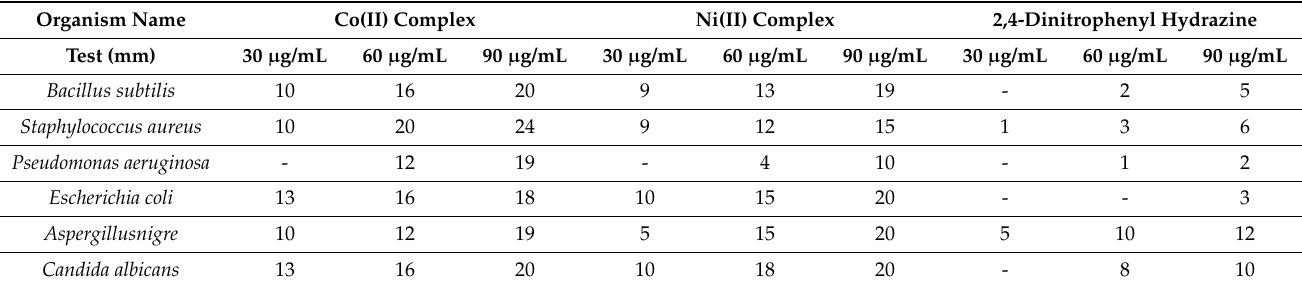
Table 4. Antimicrobial activities of DNPH and their metal